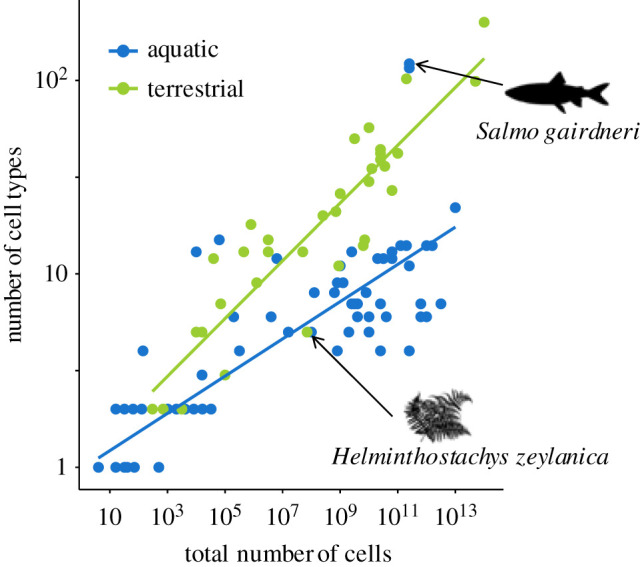
Organizational complexity and environmental constraints. Multicellular complexity, measured as both the number of cell types and the total number of cells, for species currently found in aquatic and terrestrial environments. Two notable outliers (Salmo gairdneri and Helminthostachys zeylanica) are highlighted with black arrows and images. Salmo gairdneri (rainbow trout) has an estimated 116 cell types and a total size of 2.51 × 1011 cells, which is more similar to the terrestrial Mus musculus (mouse) than to other aquatic species. Helminthostachys zeylandica (a member of the fern family) has much lower complexity for its size than other terrestrial multicellular species (just five cell types). These data have been taken from the dataset of [10].